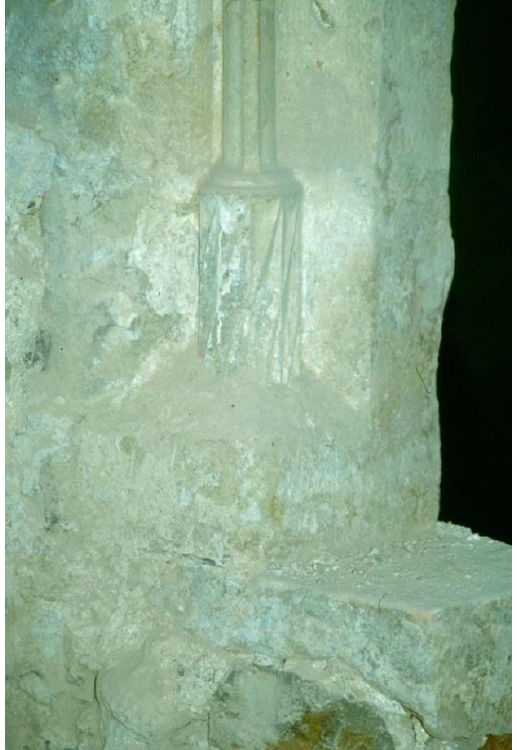
Figure 11. The entrance portal to the main hall from the west, a fragment of a rod-shape profile. Photo: The Maribor Regional Office of the IPCHS, Fond Maribor—Sinagoga.